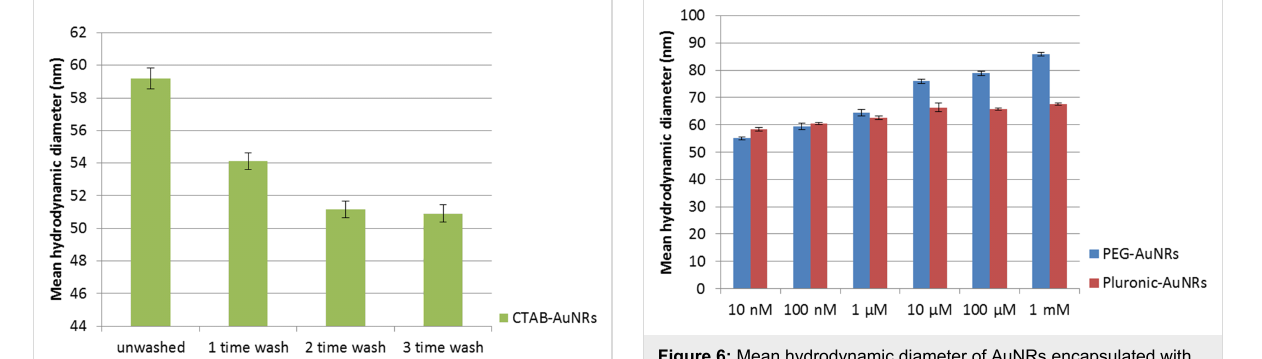
Figure 6: Mean hydrodynamic diameter of AuNRs encapsulated with different concentrations of PEG-SH or Pluronic. molecules for evaluating their biocompatibility. In accordance with the cell viability results in Figure 4, three concentrations of PEG-SH (10 nM, 1 µM, 1 mM) and Pluronic (10 nM, 100